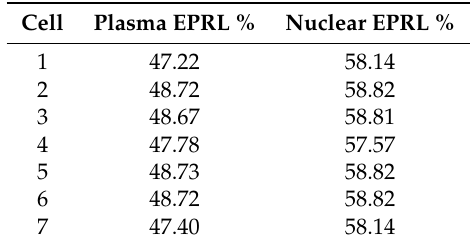
Table 4. Electroporation Relative Length of the Sparse